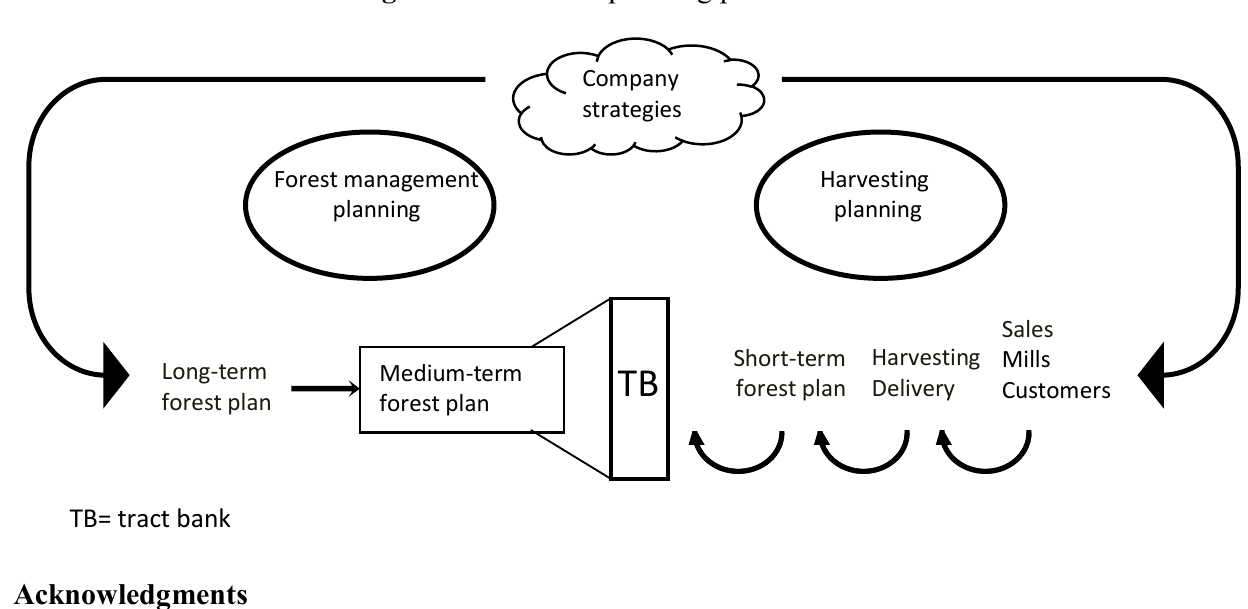
Figure 8. The forest planning process